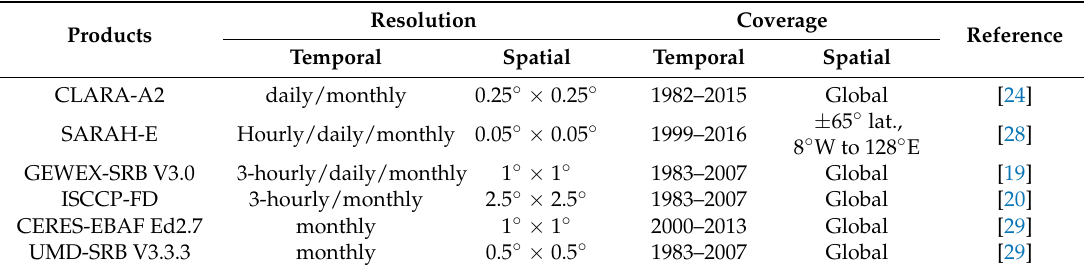
Table 1. Comparison of the resolution and coverage information of various satellite-derived surface solar radiation (SSR) products discussed in this study 1